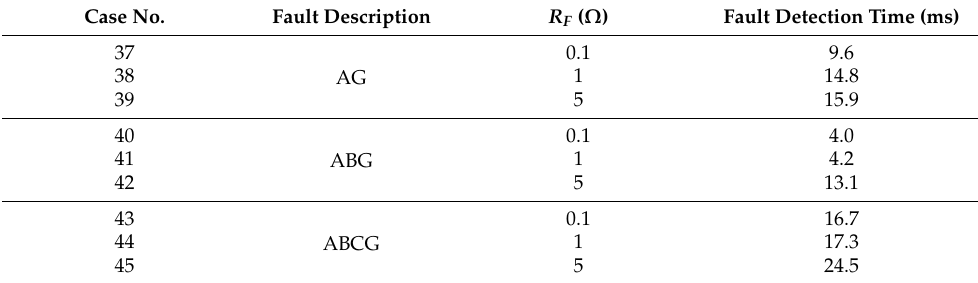
Table 5. Comparison assessment of the proposed technique with the existing IDMs.